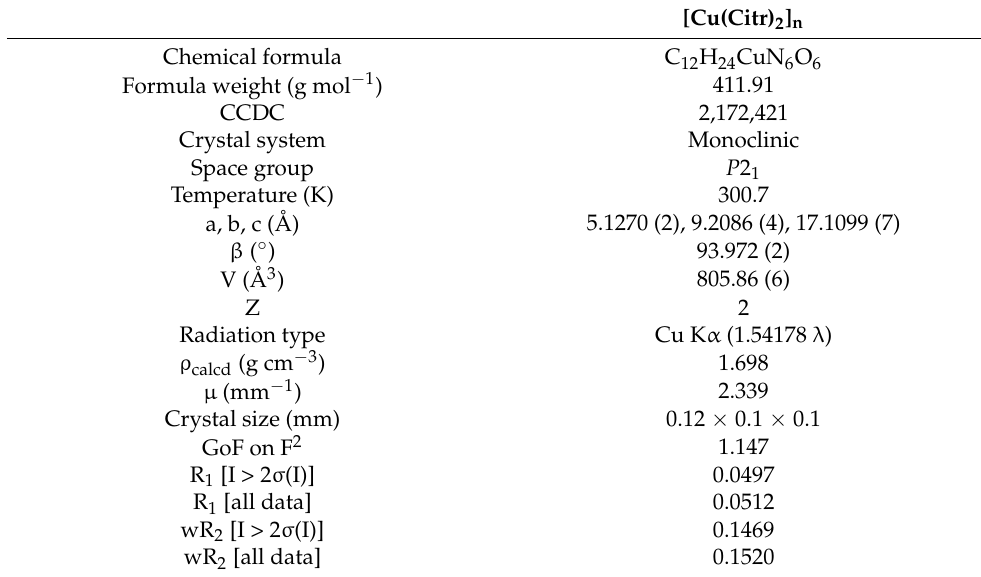
Table 1. Experimental details of the X-ray collection of